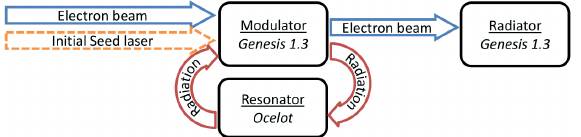
TABLE II. Total reflectivities for different seed laser wave- lengths.